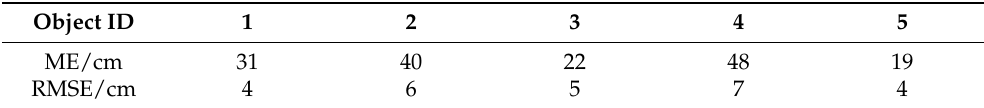
Table 5. Planar errors of the moving